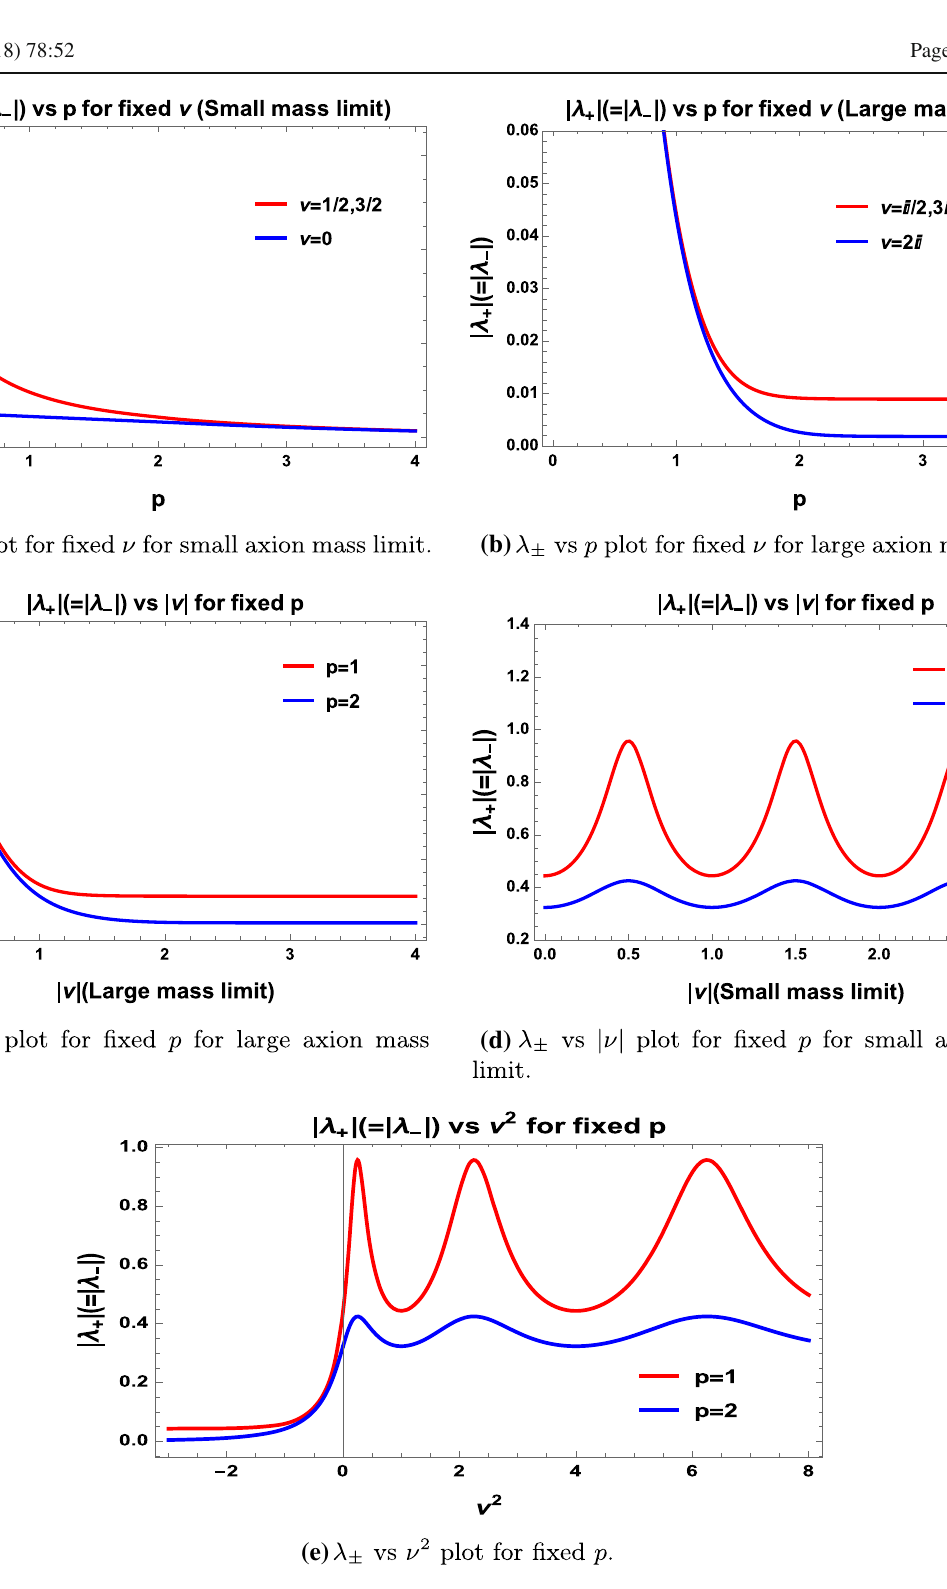
Fig. 4 Behaviour of the eigenvalues ( λ ± ) in de Sitter space for ‘ + ’ branch of solution. This figure clearly shows that we cover both large and small axion mass limit